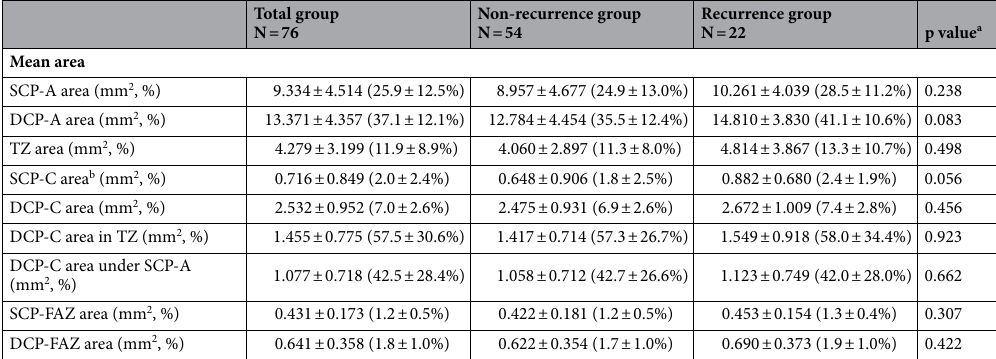
Table 2. Mean area corresponding to the segmented regions at baseline. SCP-A abnormal region of superficial capillary plexus, DCP-A abnormal region of deep capillary plexus, TZ transitional zone, SCP-C capillary congestion of superficial capillary plexus, DCP-C capillary congestion of deep capillary plexus, FAZ fovea avascular zone, SCP-FAZ foveal avascular zone of superficial capillary plexus, DCP-FAZ foveal avascular zone of deep capillary plexus. Bold font indicates a statistically significant difference (a p value < 0.05) between the non-recurrence and recurrence groups. a All values are the results of the Mann–Whitney U test. b Statistical values for 67 eyes (47 eyes in the recurrence group and 20 eyes in the non-recurrence group) in which SCP-C was